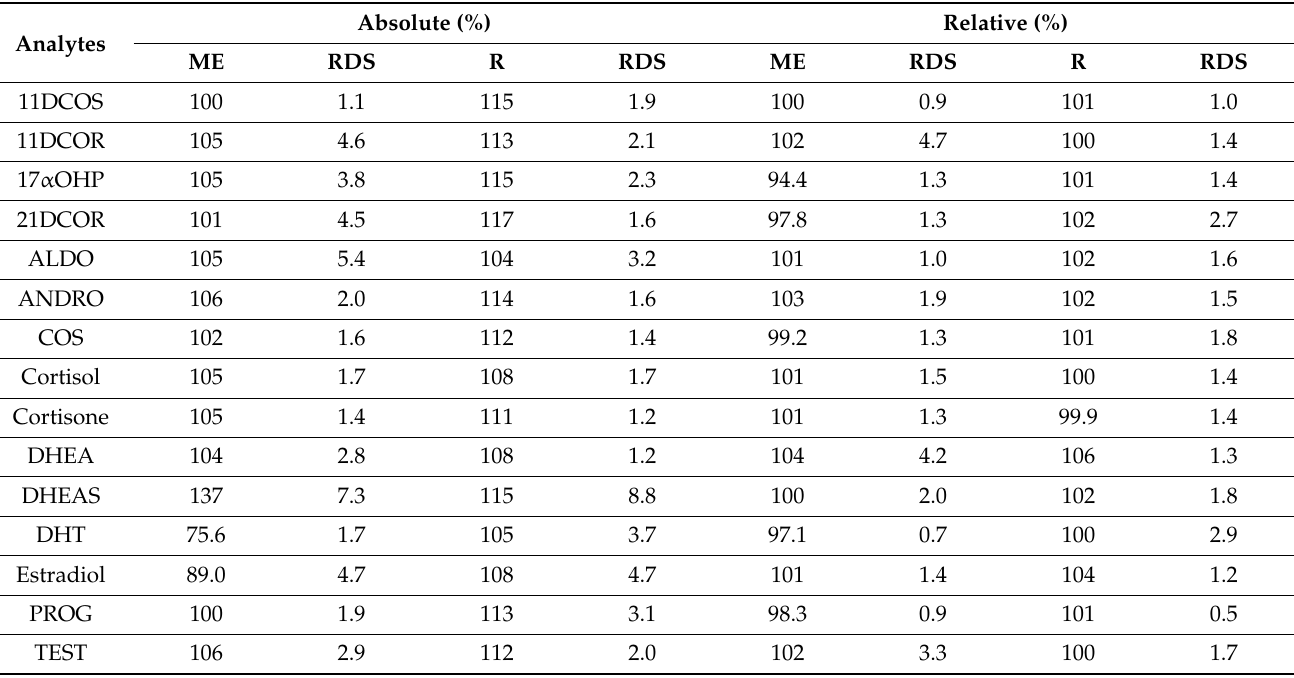
Table 2. Recovery (R) and matrix effect (ME) of particular steroid hormones in percentage with the relative standard deviation (RSD) analyses by